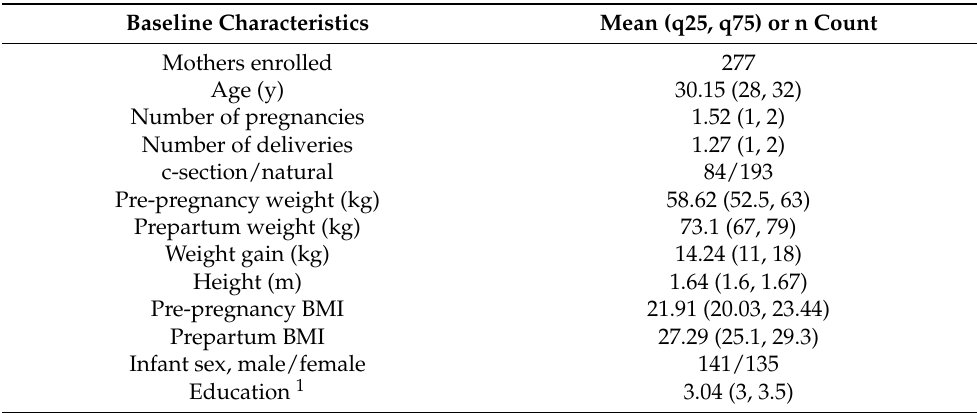
Table 1. The baseline characteristics of